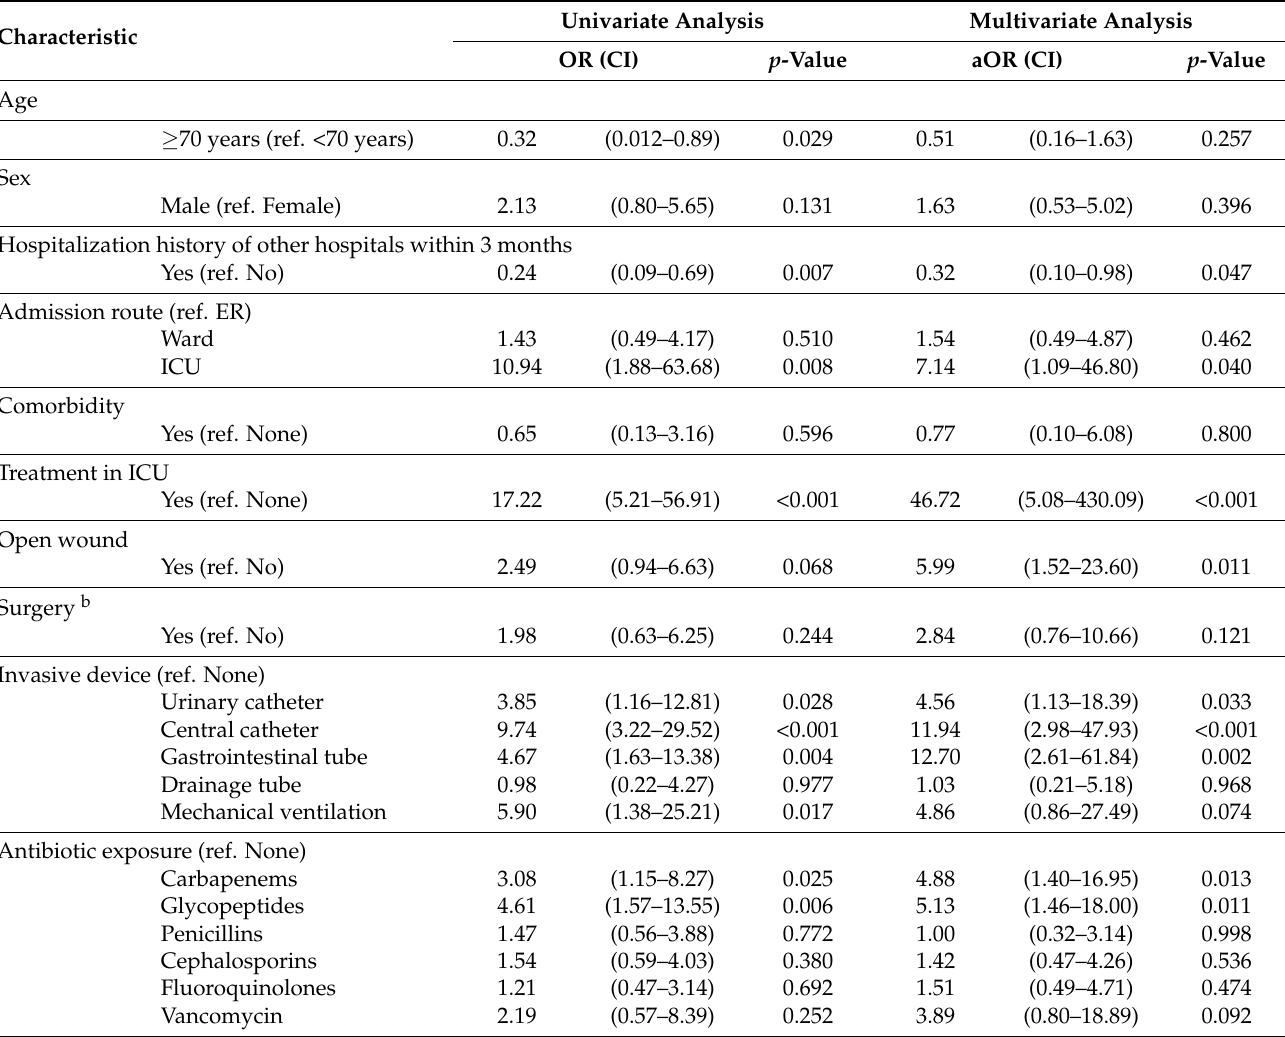
Table 3. Univariate and multivariate analyses of risk factors for CPE acquisition after hospitalization a ( n =